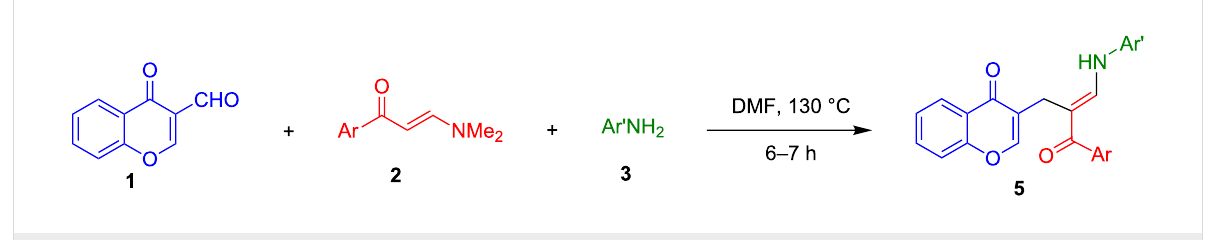
Scheme 2: Synthesis of compounds 5 .